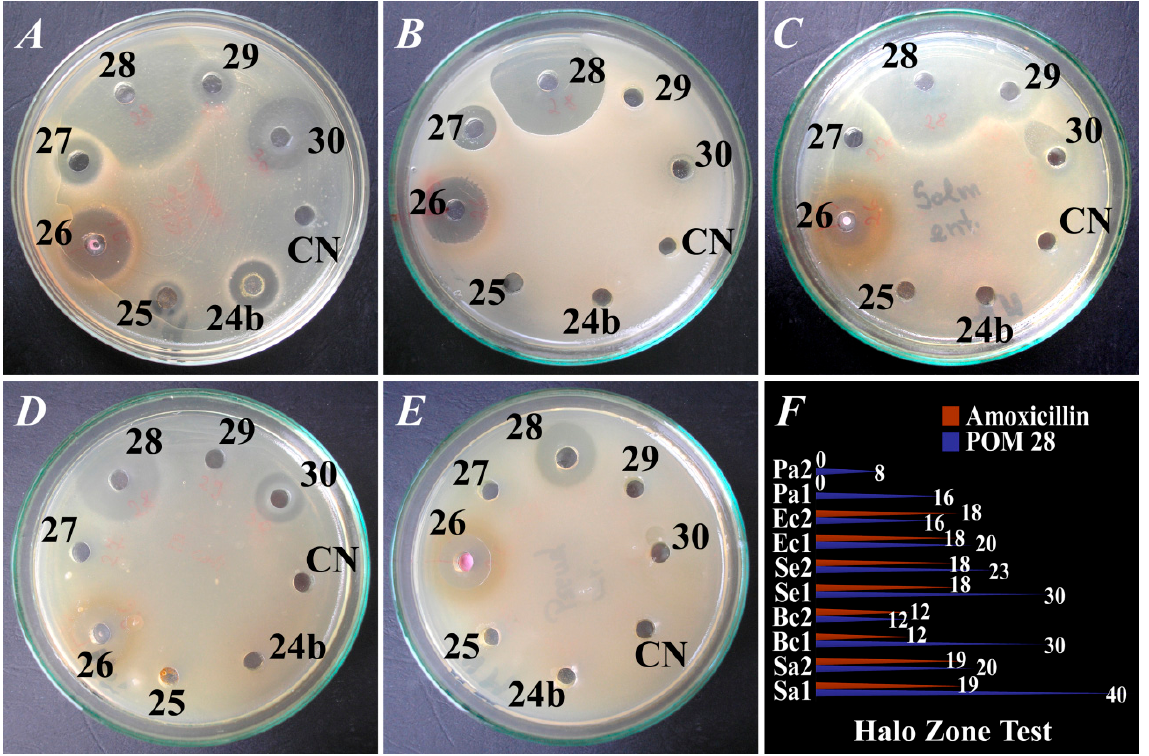
Figure 1. Antibacterial effects (assessed by the disk diffusion method) of various POMs (in black Arabic numerals) against ( A ). Staphylococcus aureus ATCC 6538P (abbreviated as Sa in panel F); ( B ). Bacillus cereus ATCC 14,579 (abbreviated as Bc in panel F); ( C ). Salmonella enteritidis ATCC 13,076 (abbreviated as Se in panel F); ( D ). Escherichia coli ATCC 10,536 (abbreviated as Ec in panel F); ( E ). Pseudomonas aeruginosa ATCC 27,853 (abbreviated as Pa in panel F); ( F ). Diameters of the inhibition zone (mm, values marked in white) of POM 28 (blue line), (NH 4 ) 4 (NBu 4 ) 5 [Na(BuSn) 3 Sb 9 W 21 O 86 ]·17H 2 O compared to Amoxicillin (red line); Sa1, Bc1, Se1, Ec1, Pa1–initial testing; Sa2, Bc2, Se2, Ec2, Pa2–retesting after 6 months. The values of the Halo Zone Test (mm) are highlighted in white on the right side of panel